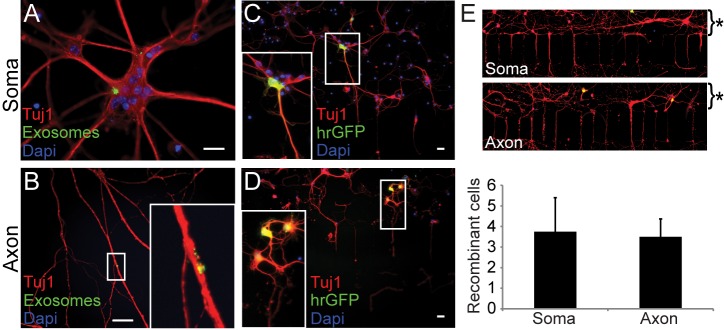
Somatodendritic and axonal uptake of exosomes.CN were cultured in microfluidic chambers and axons were allowed to grow through the microgrooves for 7 d. Exosomes isolated from PKH67 stained (A, B green) or AAV/MBP-Cre infected pOL (C, D) were applied to either the somatodendritic (A, C) or axonal (B, D) compartment of the device. Cre-containing exosomes were added to AAV/CBA-floxstop-hrGFP infected CN. hrGFP expression indicates Cre-mediated recombination (C, D green). CN were stained with Tuj1 (red) and nuclei with Dapi (blue). Scale bar, 20 µm. (E) Quantification of recombinant neurons located within 100 µm above the microgrooves. Exemplary pictures are depicted above the chart. Asterisk indicates the area of quantification. Error bars, SEM (n = 4).